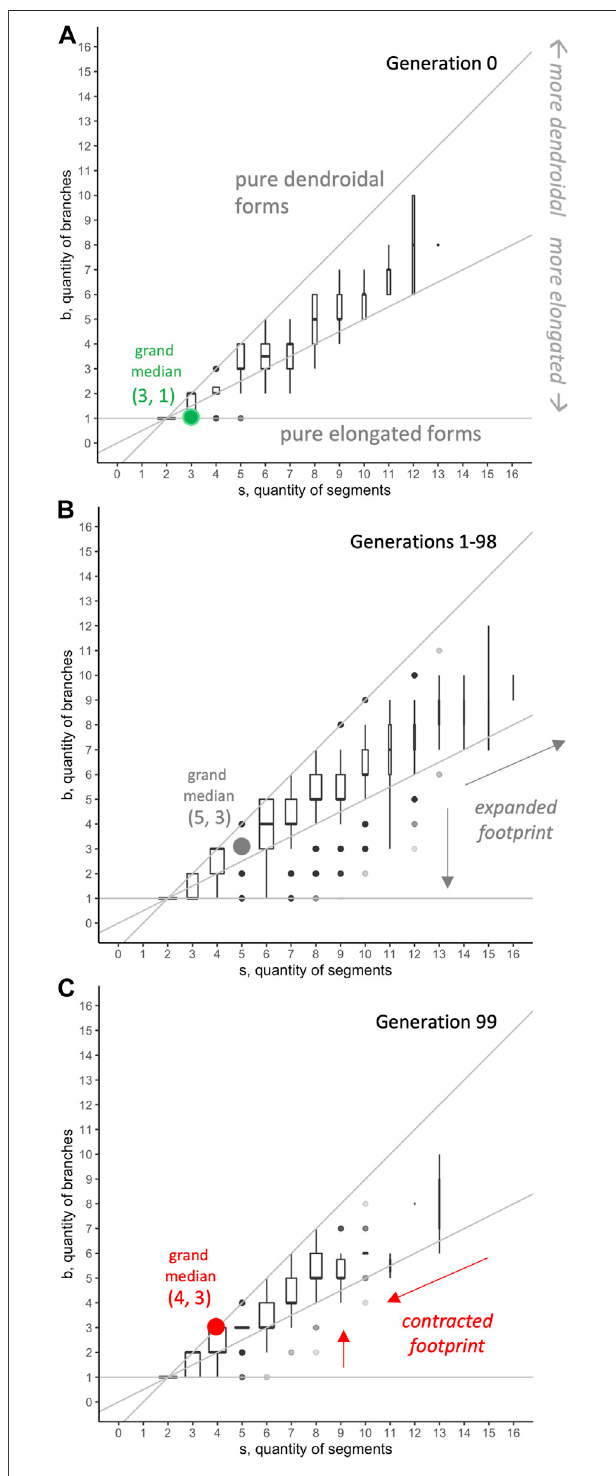
FIGURE 10 | Morphospace analysis: distribution of s - b body forms. In generation 0 (A) , the randomly generated morphologies show a clear dendroidal bias, with all median values falling in the region where body forms are more dendroidal than elongated. That same dendroidal bias is